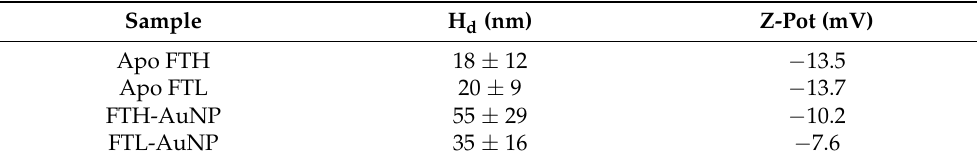
Table 3. Monomeric/oligomeric fraction analysis from size exclusion